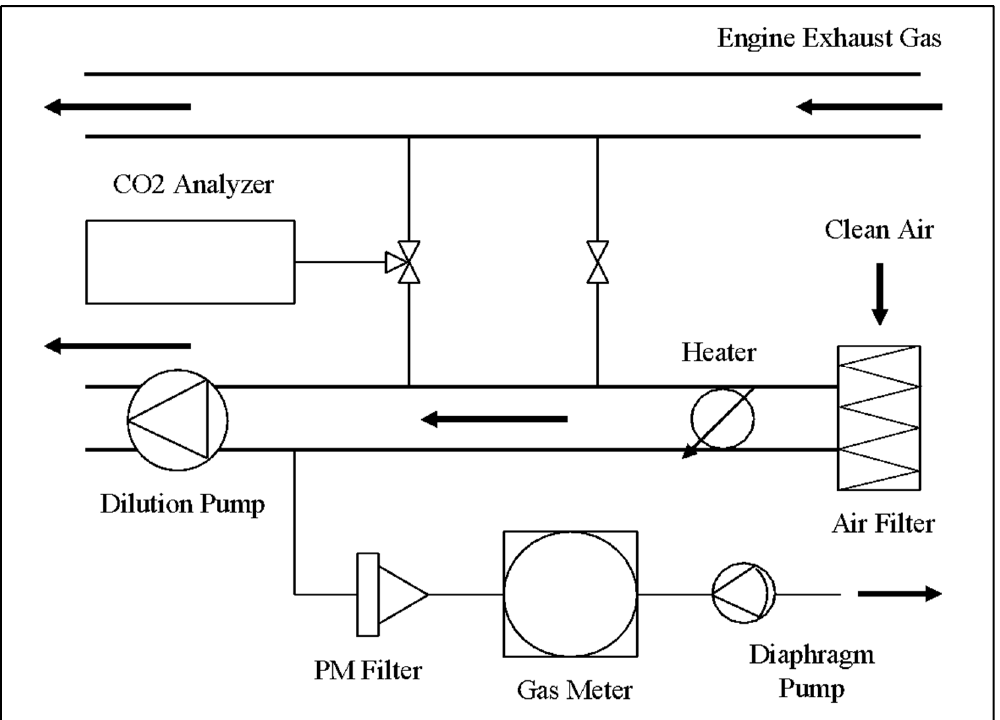
Figure 4. Schematic diagram of a minidilution tunnel.